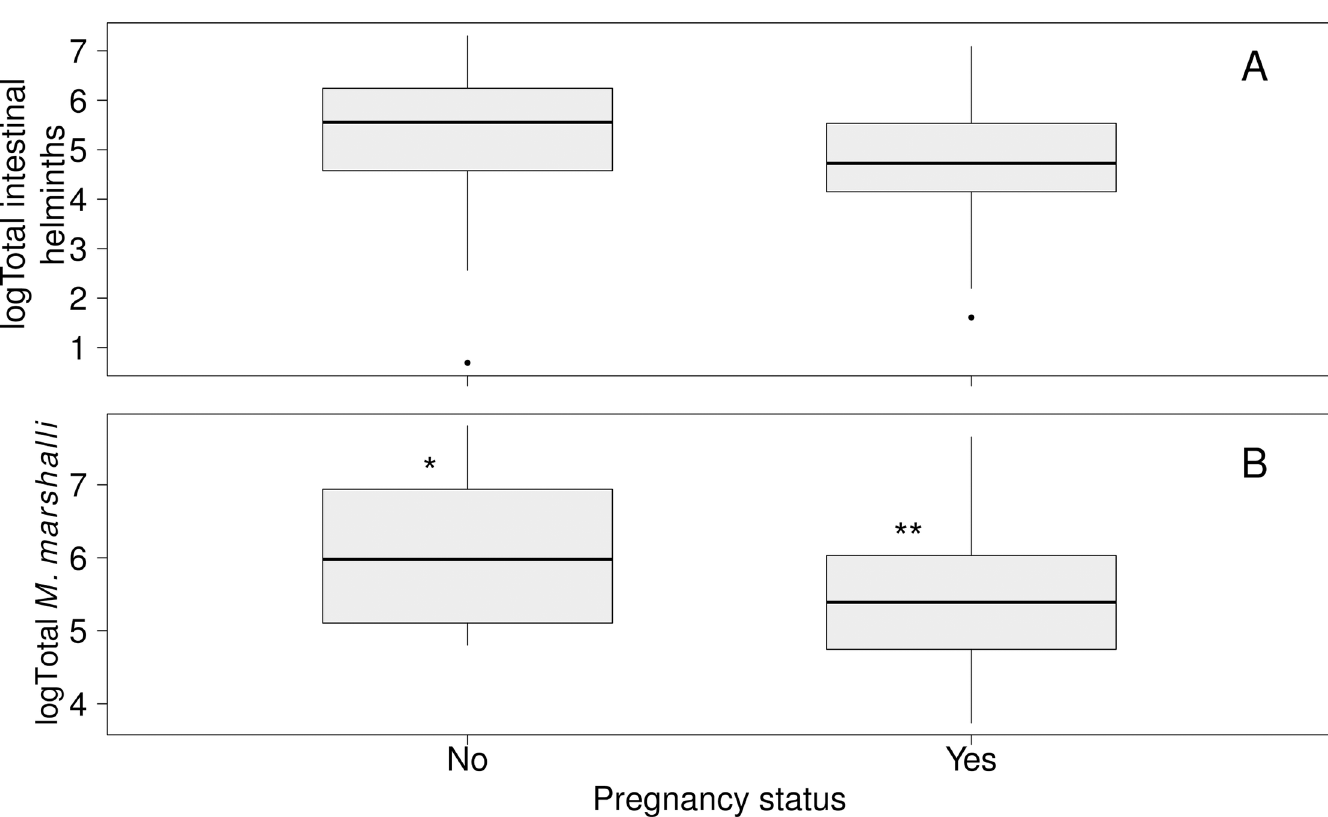
Fig 5. Infection intensity of gastrointestinal helminths in adult female Dall’s sheep categorized by pregnancy status. A) Total infection intensity of intestinal helminths (t-test, t = 1.598, df = 25.96, p-value = 0.122). B) Infection intensity of Marshallagia marshalli (: t-test, t = 2.444, df = 24.753, p-value = 0.0220). Significant difference among categories (p < 0.05) are represented with different numbers of “ (cid:3) ”.